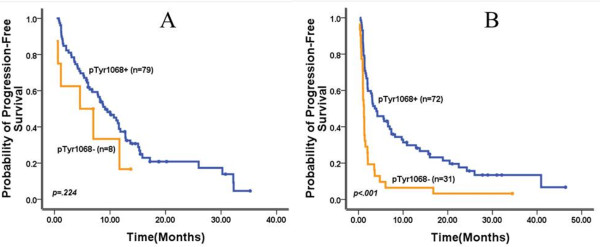
Progression-free survival curves in subgroup patients with epidermal growth factor receptor mutation positive (A) and negative (B) according to phosphorylated tyrosine (pTyr)1068 espression.